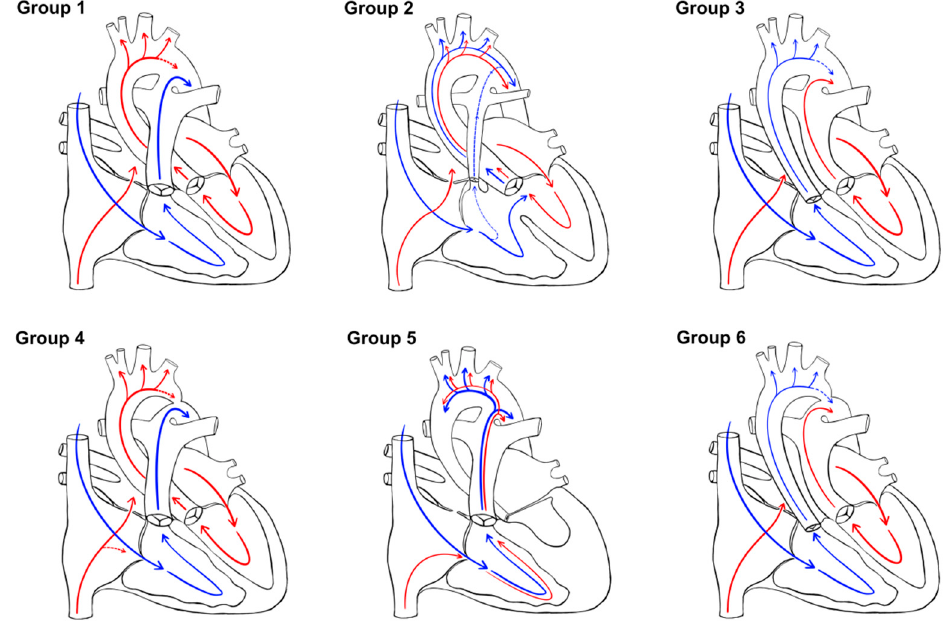
Figure 1. Congenital heart disease classification based on expected oxygen delivery to the brain (normal, mixed, and low), and antegrade aortic flow (obstructed or not). Group 1: normal oxygen with normal aortic flow (no obstruction) (CHD without significant intracardiac shunt); Group 2: mixed oxygen with normal aortic flow (no obstruction) (CHD with intracardiac shunt); Group 3: low oxygen with normal aortic flow (no obstruction) (TGA physiology without significant intracardiac shunt); Group 4: normal oxygen with obstructed aortic flow (CHD without significant intracardiac shunt); Group 5: mixed oxygen with obstructed aortic flow (CHD with intracardiac shunt, mainly HLHS); Group 6: low oxygen with obstructed perfusion (TGA physiology without significant intracardiac shunt). CHD: congenital heart disease, TGA: transposition of the great arteries, HLHS: hypoplastic left heart syndrome.